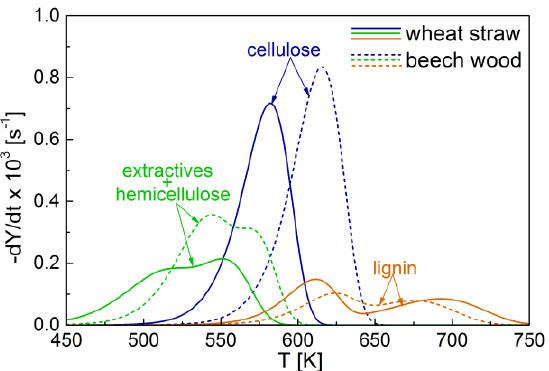
Figure 5. Predicted mass-loss rate for wheat straw (solid lines) and beech wood (dashed lines) [22] (data in Table 2A,B), − dY/dt from their pseudo-macrocomponents versus temperature (heating rate 5 K/min, up to 773 K).